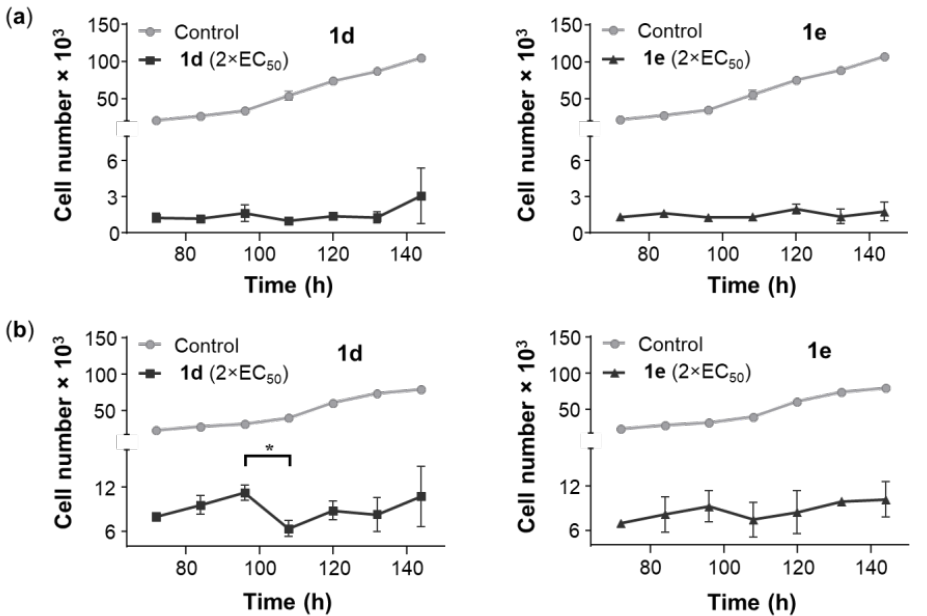
Figure 4. To study the drug withdrawal effect on A549 and NCI-H522 cell proliferation, ( a ) A549 cells (2000 cells/well) were treated with 0.72 µM of 1d and 0.64 µM of 1e , while ( b ) NCI-H522 cells (5000 cells/well) were treated with 0.56 µM of 1d and 0.46 µM of 1e , both for 72 h. Vehicle control cells were treated with DMSO (0.5%). Compound-containing medium was replaced with fresh medium, and the cells were allowed to grow for another 72 h. At the end of the treatment period, the cell number was determined by the SRB assay. The points represent the mean ± SEM ( n = 3). Data were analyzed using a two-way ANOVA coupled with a Bonferroni post hoc test. * Indicates a significant difference between the data points, p < 0.01.